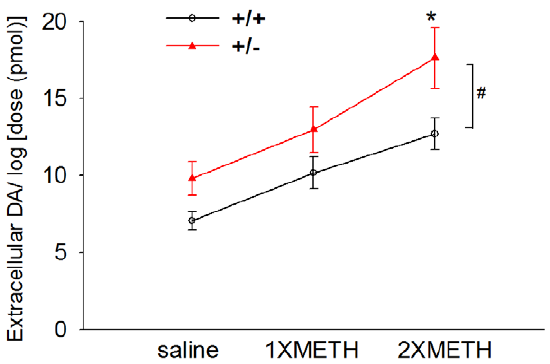
Figure 6. Further reduction of DA clearance in the striatum after repeated METH binge in Nurr-1 + / 2 mice. Extracellular DA concentration was measured using chronoamperometry after local application of low doses (10.2 + / 2 0.6 pmole/site) of DA through micropipettes in mouse striatum after saline, 1xMETH or 2XMETH treatment. Amplitude of DA signals was normalized by comparison to the log of dose used. Extracellular DA concentration was significantly enhanced in Nurr1 + / 2 , compared to + / + mice, after 2XMETH treatment (*, p , 0.05, Two-way ANOVA, post hoc Newman-Keuls test).